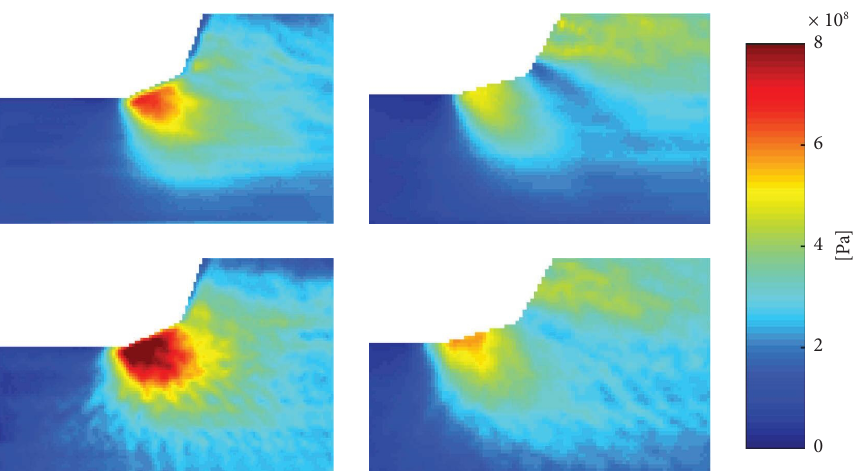
Figure 13: Averaged volumetric stress with 30RPM (top) and 90RPM (down) using models with rate-dependent normal bond strength (left) and grain elastoplasticity